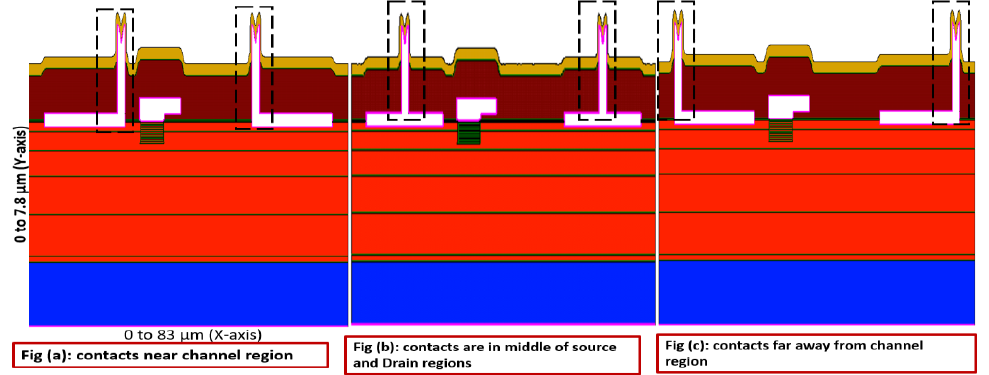
Figure 2. Simulated device structure with three various metal contact positions. Table 1. Physical models for simulation of normally off AlGaN/GaN HEMT device.